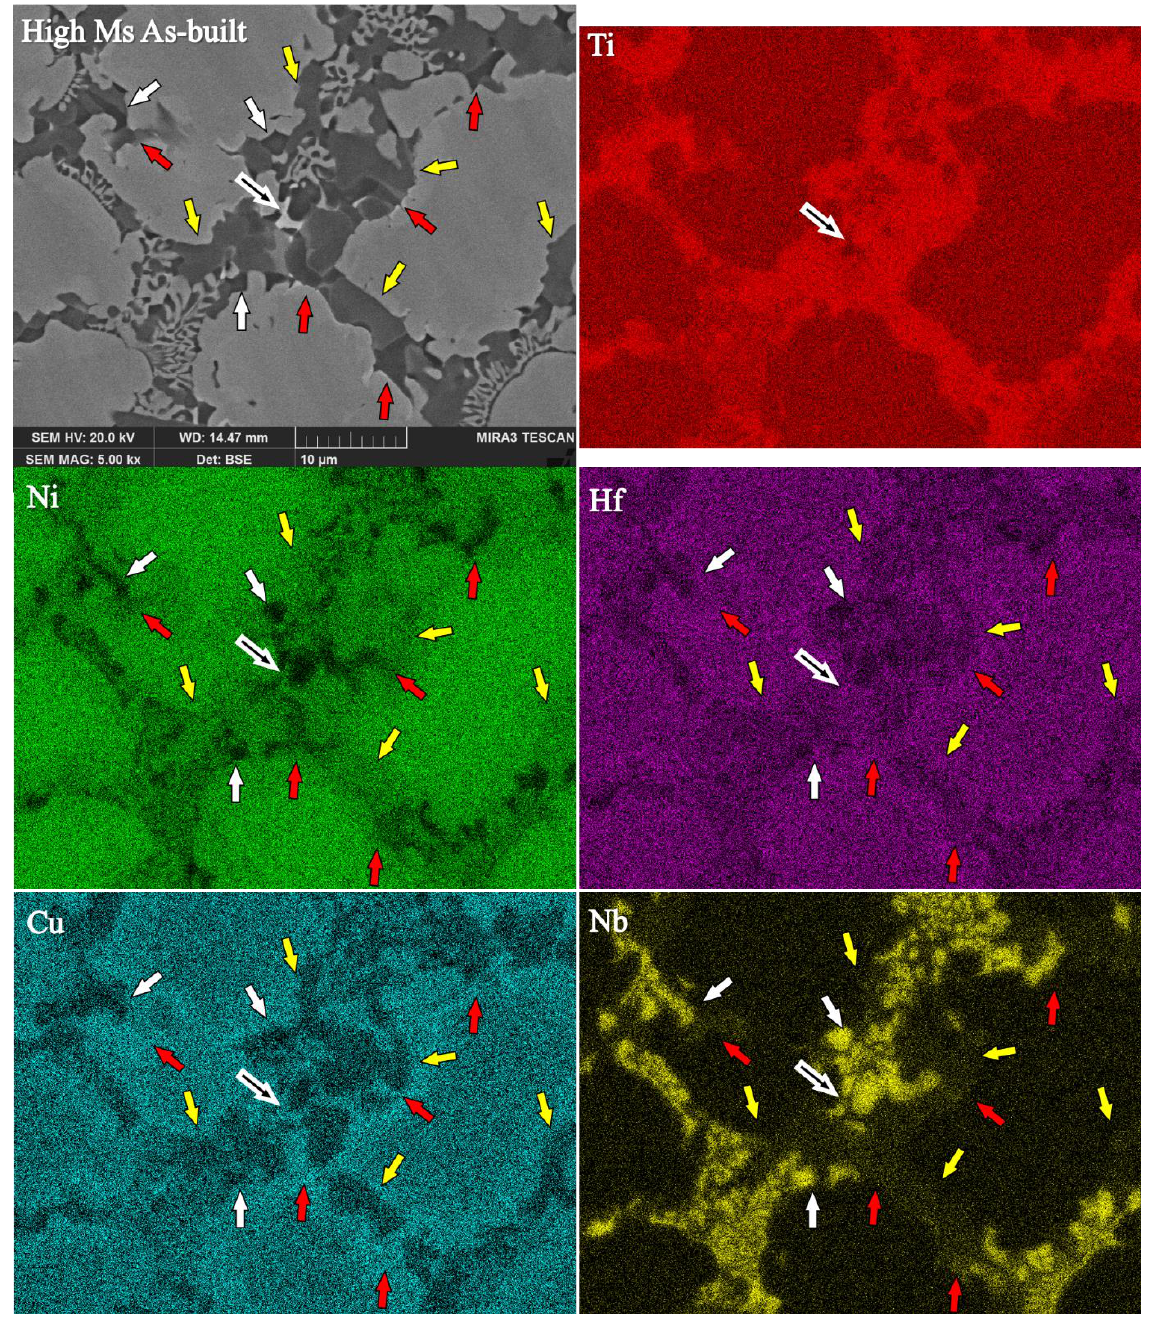
Figure 10. EDS mapping around the precipitates in Ti 44 Ni 34 Hf 10 Cu 10 Nb 2 high M s sample shows three different types of precipitates indicated by white, red and yellow arrows.